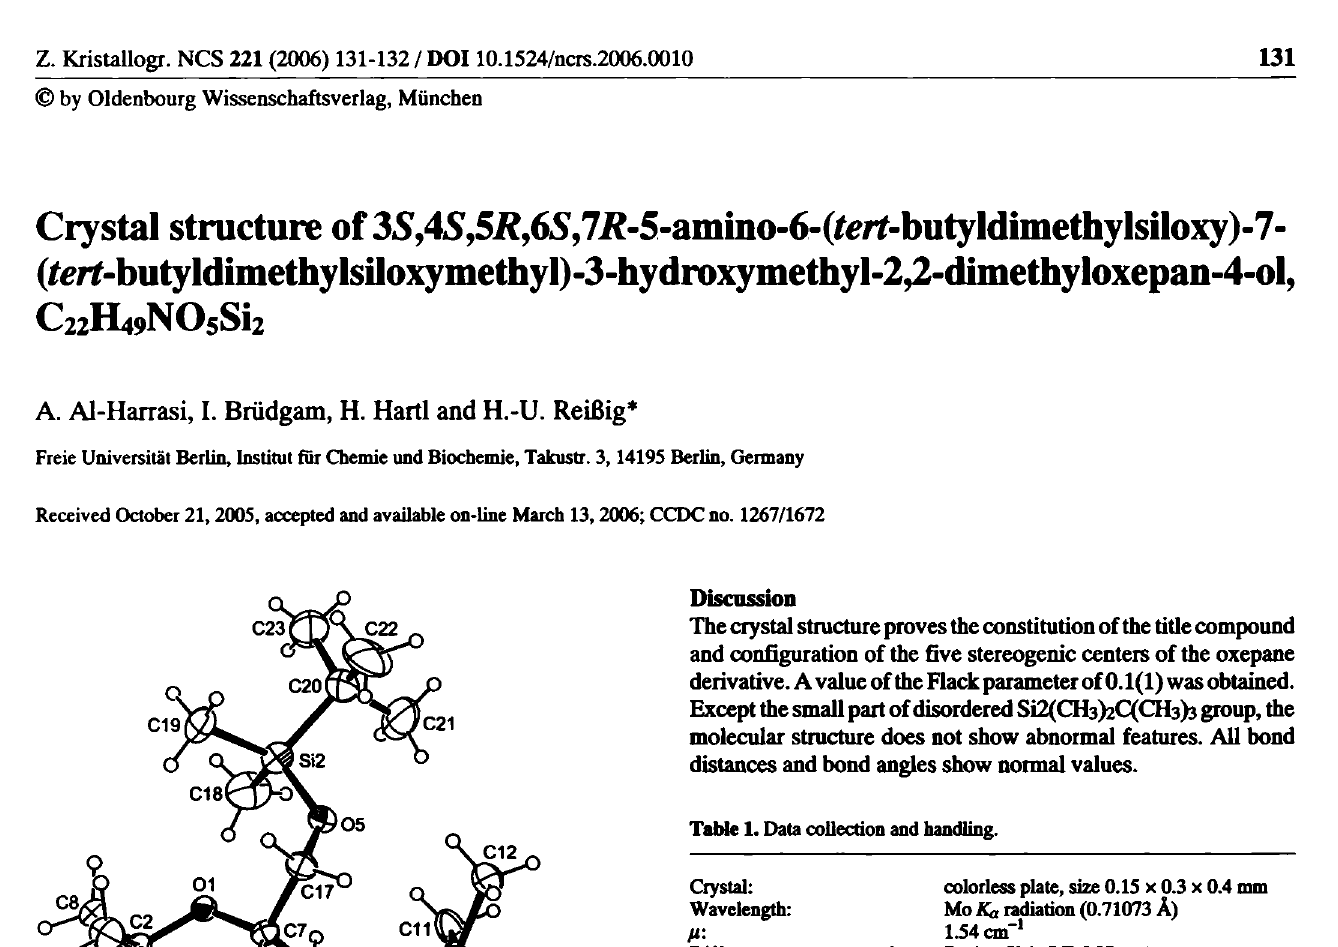
Table 2. Atomic coordinates and displacement parameters (in A 2